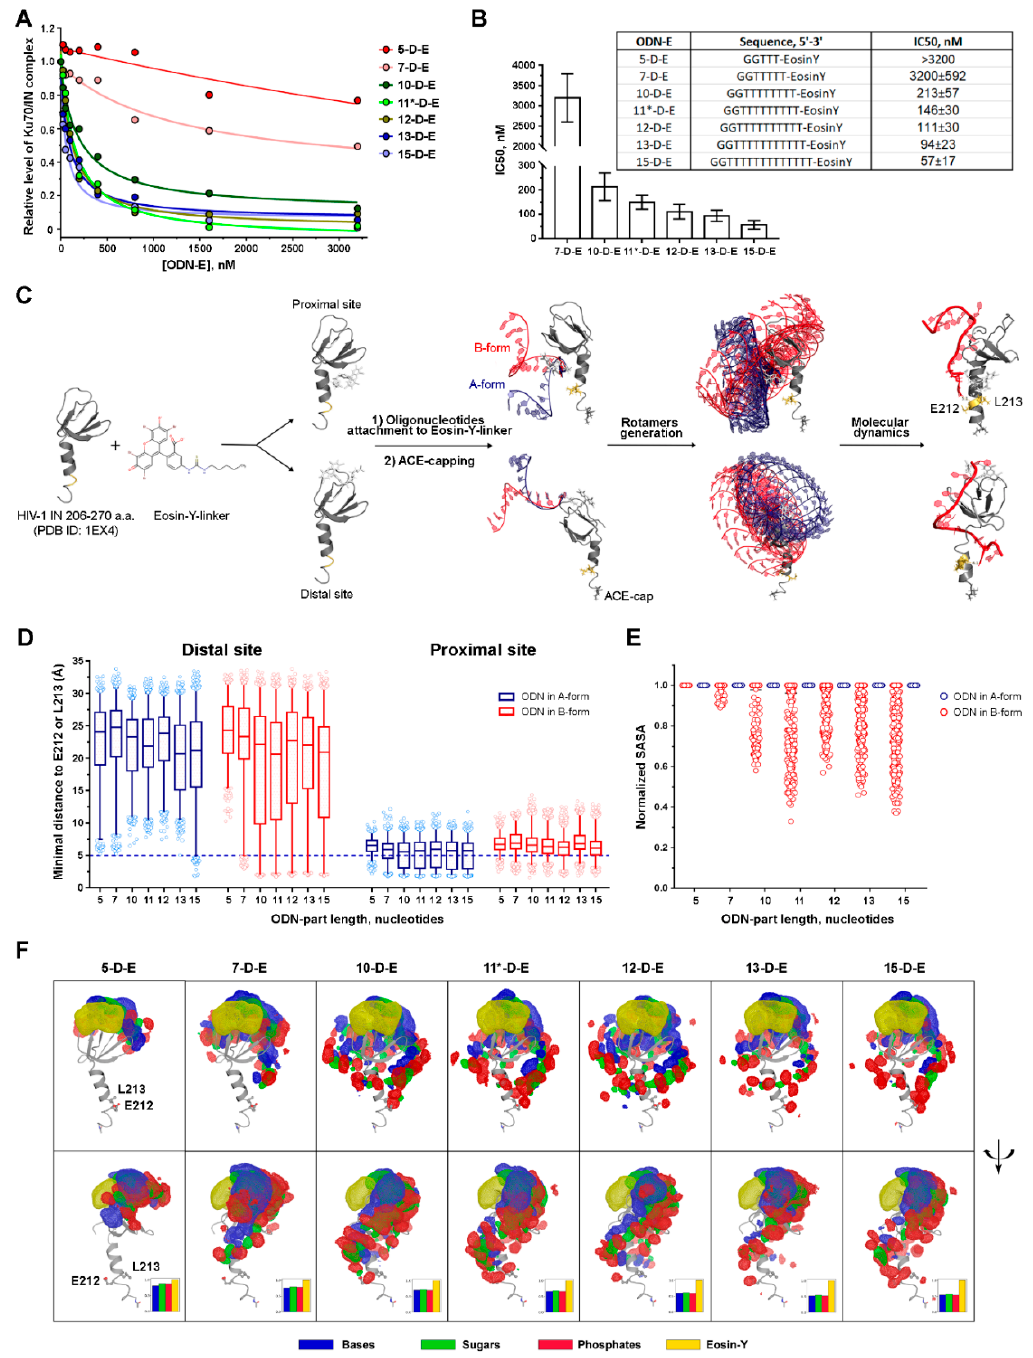
Figure 3. An effect of the oligodeoxynucleotide length of ODN-E on the complex formation between the Ku70 and HIV-1 integrase. ( A ) Fluorescent pull-down assay analysis of the interaction of His 6 -Ku70-tRFP (200 nM) and GST-mCer-IN (200 nM) in presence of an increasing concentration of ODN-E with different size of ODN part (5–15 nucleotides). ( B ) ODN-E sequences and IC50 values measured in a fluorescent pull-down assay. ( C ) The pipeline of the molecular dynamics experiments for IN/ODN-E systems. Eosin-Y+linker was docked to the HIV-1 IN (PDB ID 1EX4, residues 206–270) and two complexes with Eosin-Y+linker bound at proximal and distal sites were obtained. After that, DNA oligonucleotides in either A or B forms were attached to the Eosin-Y+linker. To prevent the undesirable interactions between ODN-E and N-terminal charged amino group ACE-cap (acetyl group) was added to the N-terminus. The molecular dynamics simulations were carried out after the rotamers generation as described in the Materials and Methods section.( D ) Distribution of minimal distances between atoms of the ODN-E and the Е 212/L213 residues of IN for different starting